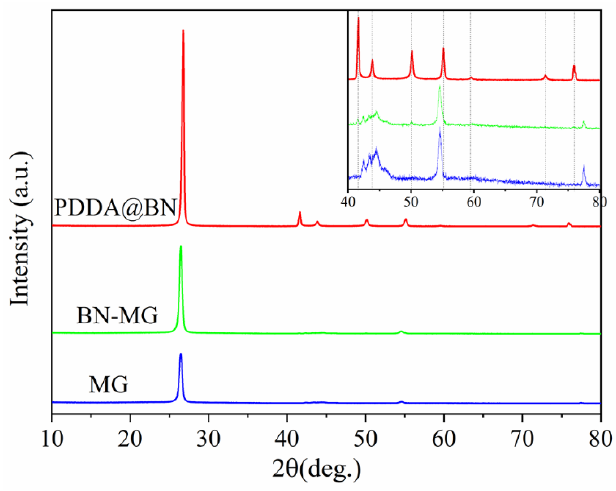
Figure 4. FT − IR spectra of BN,PDDA@BN, MG, and BN − MG. The crystal structure of PDDA@BN, MG, and BN − MG are shown in Figure 5. The strong and sharp peak at 2θ = 26.0° is the characteristic peak of MGcorresponding to the (002) crystal plane diffraction of MG. The strong characteristic (002) crystal plane diffrac- tion peak of BN is at 2θ = 26.9° . Diffraction peaks at 2θ =41.6°, 43.8°, 50.2°, 55.1° , and 76.0° correspond to the (100), (101), (102), (004), and (110) crystal plane of BN in accordance with the reference data of JCPDS card No.34 − 0421. When compared with MG, BN − MG has five new diffraction peaks at 2θ = 41.6°, 43.8°, 50.2°, 55.1°, and 76.0°. These new five diffraction peaks correspond to the (100), (101), (102), (004), and (110) crystal planes of BN and further confirm that BN had successfully coated on the surface of MG through electrostatic self − assembly.